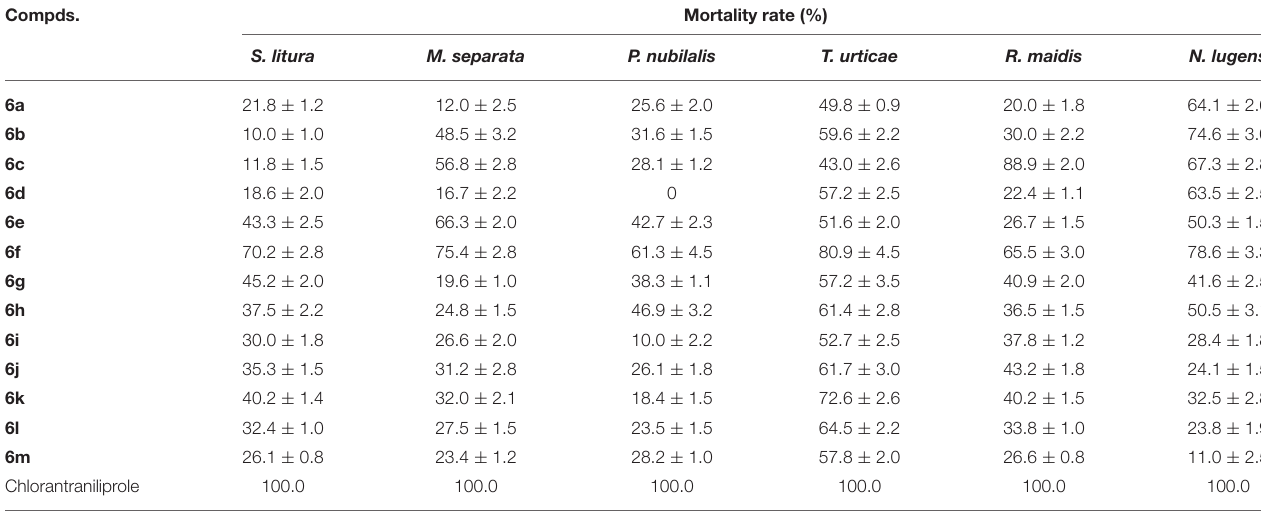
TABLE 3 | The insecticidal activities of the title compounds 6a–6m at 200 µ g/mL.